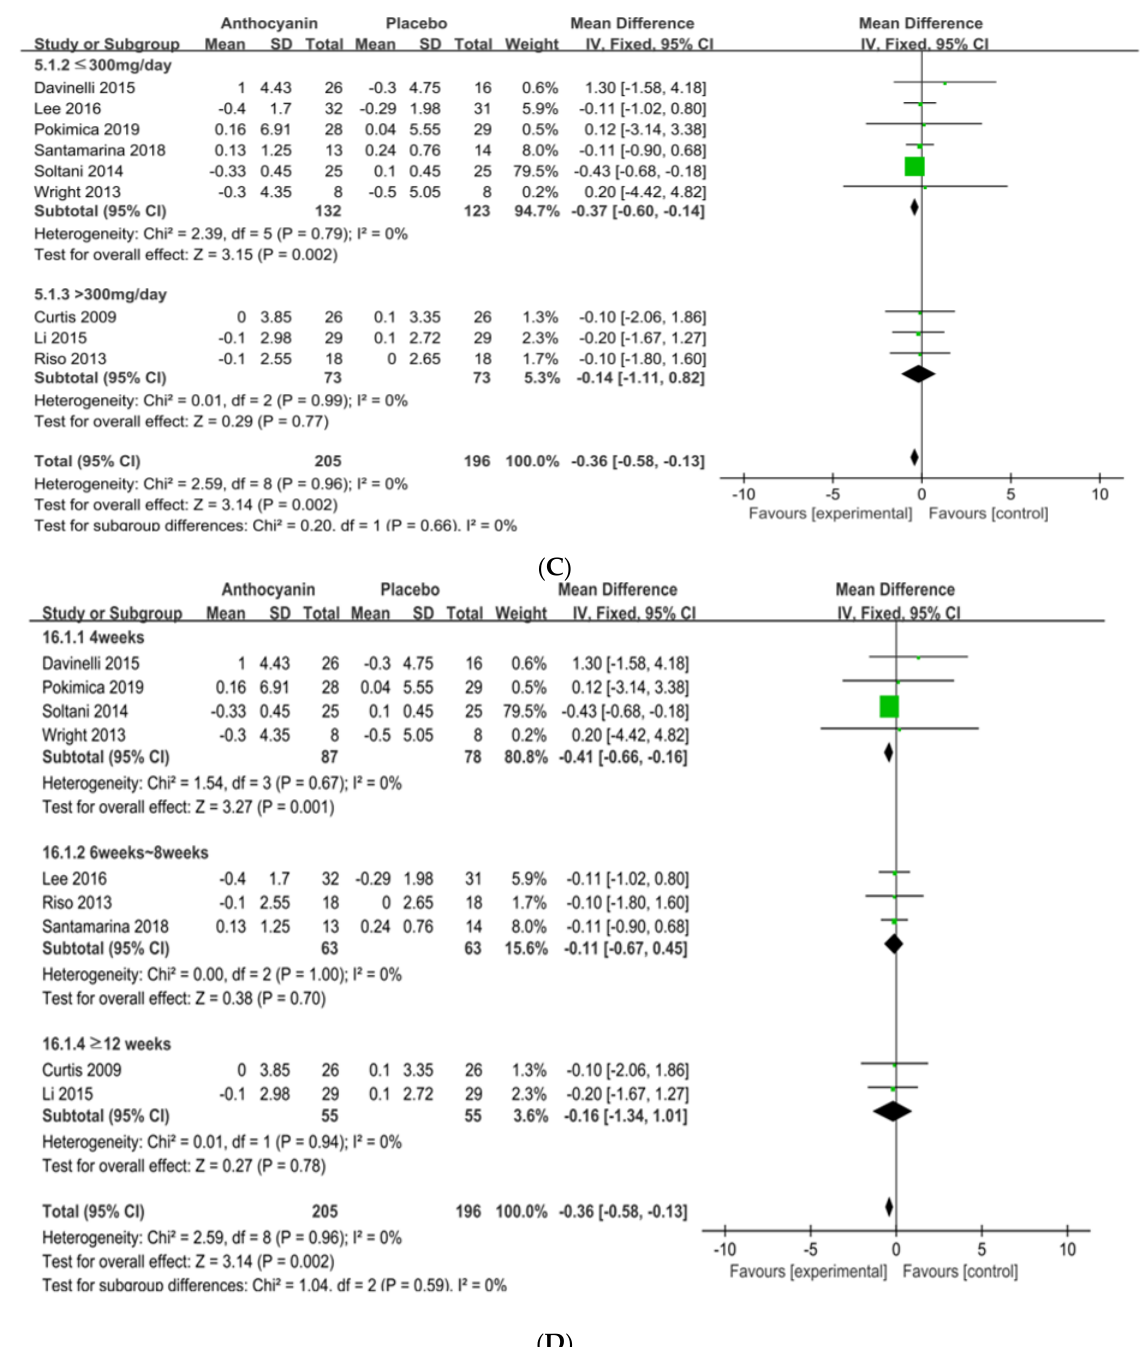
Figure 3. Forest plot of BMI changes ( A ) and subgroup analysis by obesity degree ( B ), intervention levels ( C ), and intervention periods ( D ). Abbreviations: SD: standard deviation, CI: confidence interval, df:degrees of freedom, Statistical heterogeneity was assessed by I 2 test, Chochran's Q-test; I 2 : Higgin's I 2 test, Chi 2 : Cochran's Q-test, IV: inverse variance, Z: Z-score, P: P-value.